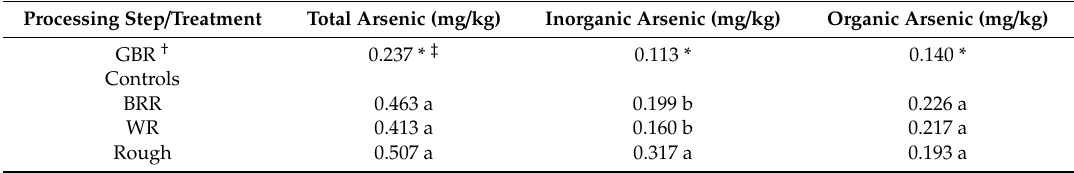
Table 5. Concentration of arsenic species in Rondo rice, as tracked from stored rough rice (paddy) through dehulling, milling and after rinsing and sprouting, resulting in germinated brown rice. Processing Step /